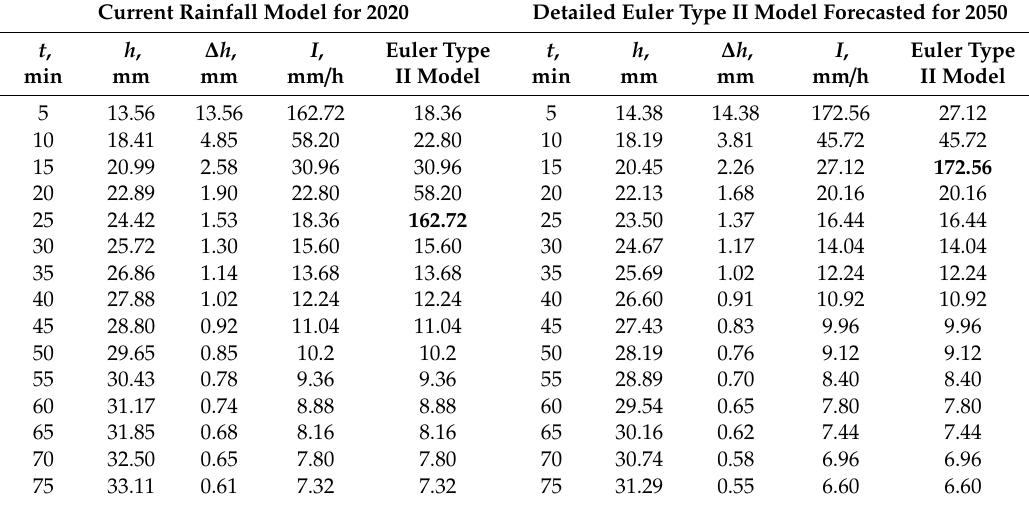
Table 4. Stages of creating Euler type II model for current form of the model for 2020 and for the detailed form forecast for 2050—for the example occurrence frequency C = 10 years and duration t = 75 min (the highest interval intensities are